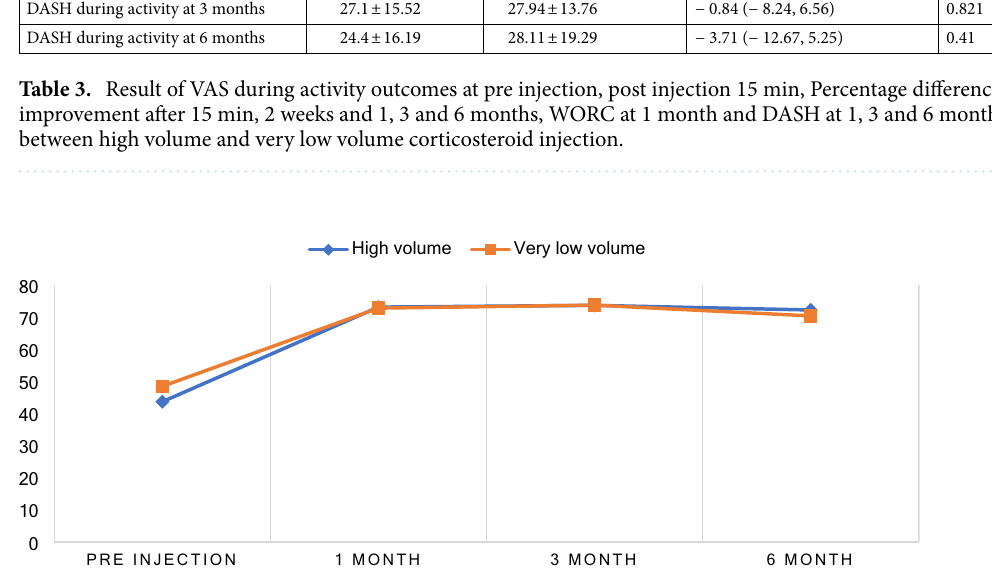
Figure 3. Mean WORC score by the progression time to treatment with